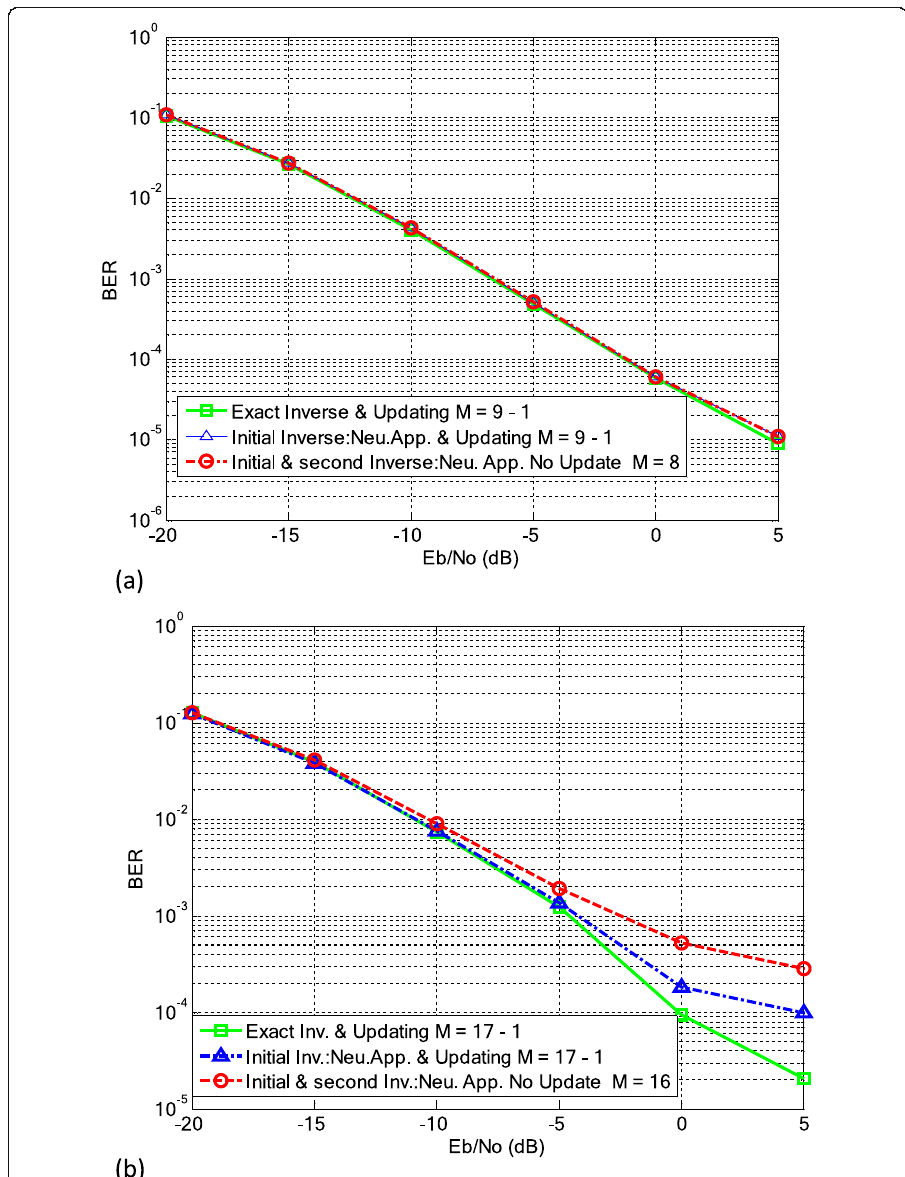
Fig. 4 BER performance comparison for deflation update and the number of current users M = 9 , 17. BS is equipped with N = 320 antennas that serves M = 9, 17 users. Assuming that a user is removed from the system the proposed algorithm is used to update the inverse matrix for decoding. The results for M = 9 is shown in simulation a and simulation b demonstrates the comparison results for M = 17 after a user exits the cell. As it is predictable, the BER performance of the exact inverse matrix update algorithm is better than the approximation